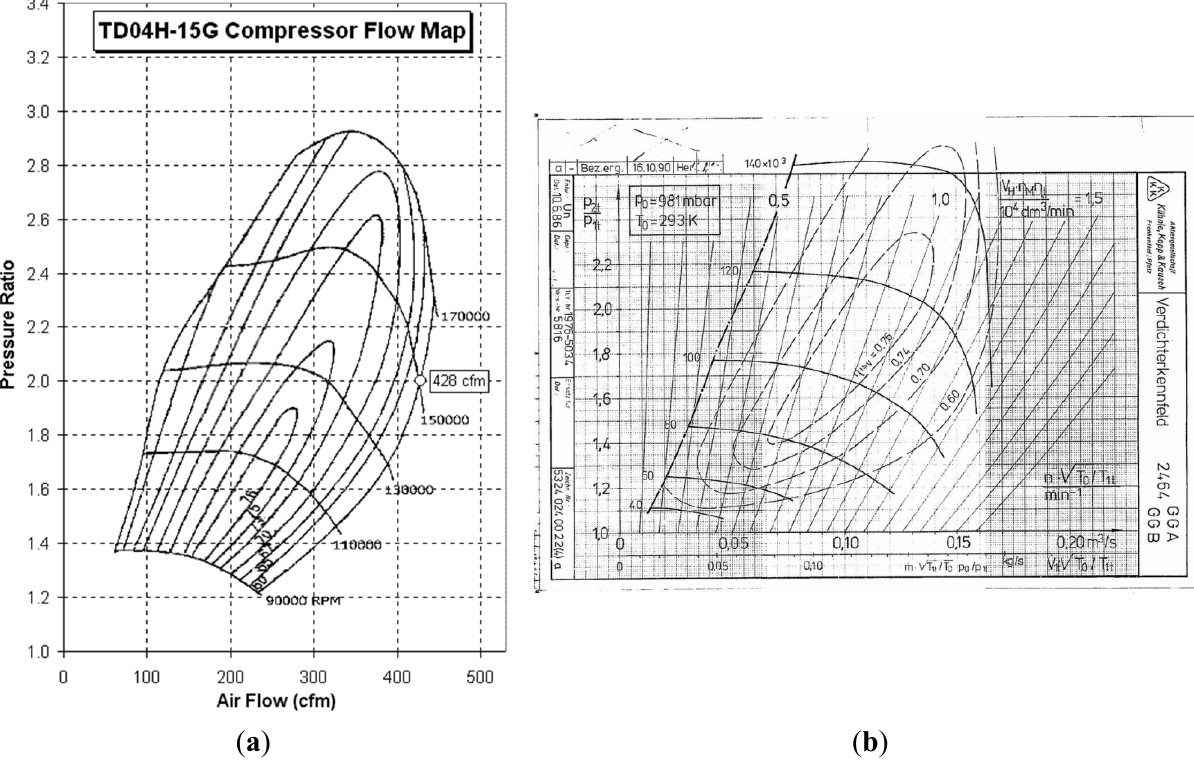
Figure 6. Compressor maps for ( a ) the Mitsubishi TD04 09B and ( b ) the KKK 04-14 used for the comparison and evaluation of proposed Equation (5).